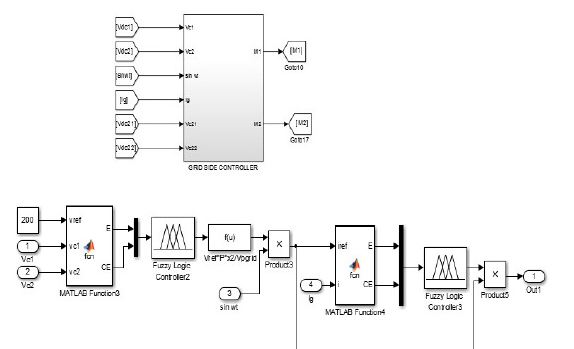
Fig 19: Simulink diagram of grid side fuzzy logic controller